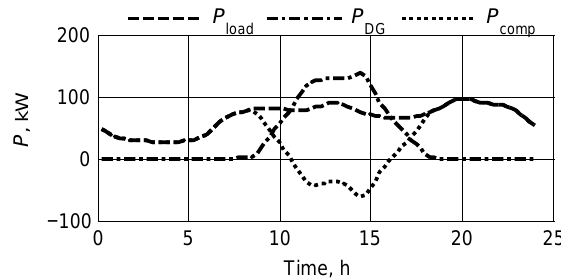
Fig. 12. Prediction curve for P load , P DG and the resulting P comp (scenario 4).